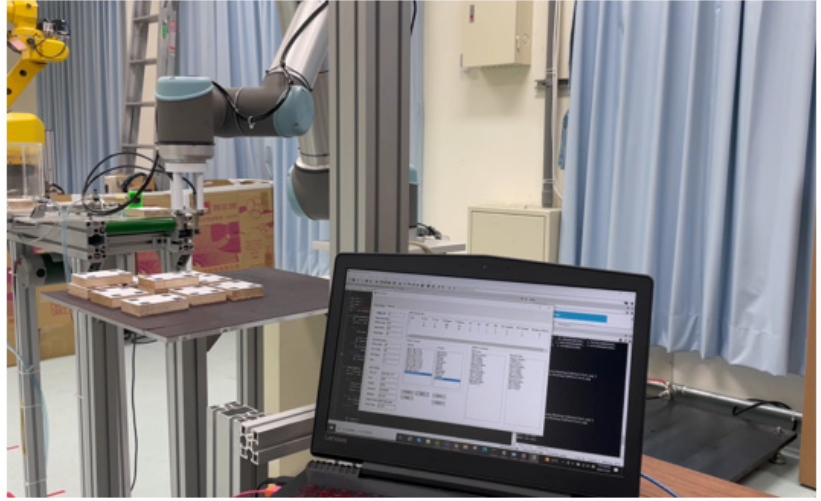
Figure 39. Normal palletizing in workstation.